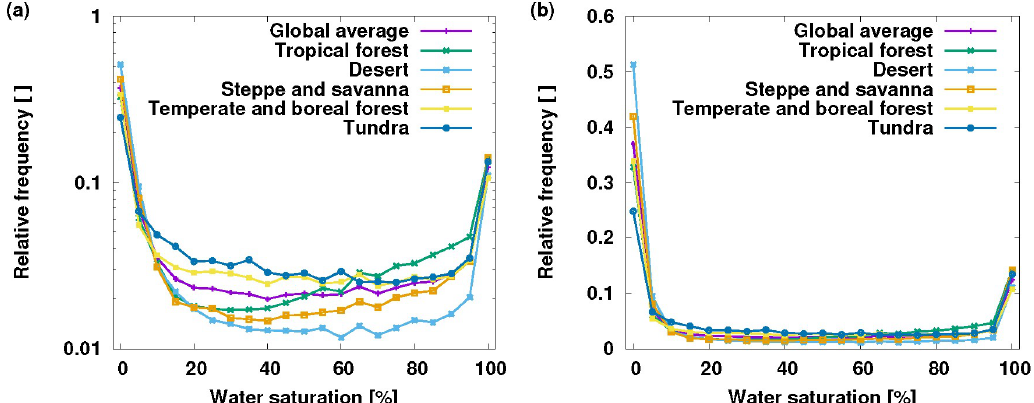
Figure 3. Saturation state of non-vascular epiphytes simulated by the lichens and bryophytes (LiBry) model—( a ) frequency on a logarithmic axis to better identify differences between biomes, ( b ) the same data with a linear axis. Global average is shown with values for five ecosystem classes, based on the world’s biomes [62]. Tropical forest also includes subtropical forests, and desert includes the Mediterranean biome. The resolution of the x-axis is 5%, thus the highest saturation state corresponds to the range 95%–100%.